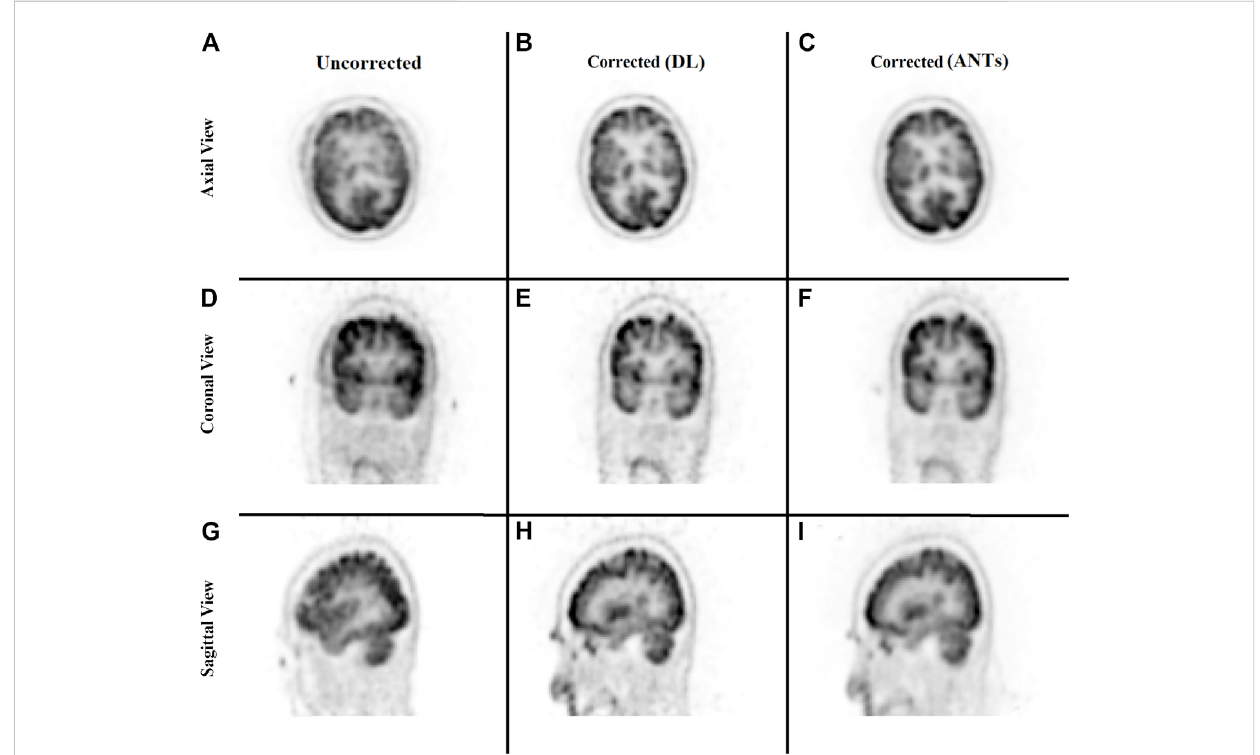
FIGURE 5 Qualitative comparisonoftheneuralnetworkperformanceinmotion correctionbymeansofframe-by-frameimageregistration.Rowsfromtopto bottom show the sum of the three frames without any correction (A, D, G) , correction using the deep learning approach (B, E, H) , and the ANTs iterative algorithm (C, F, I) , respectively, in the axial, coronal, and sagittal view.